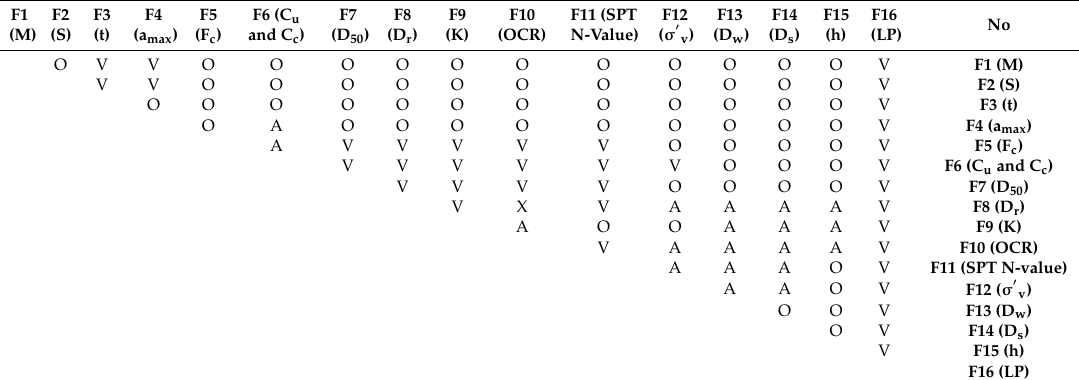
Table 3. Structural self-interaction matrix for soil liquefaction factors.